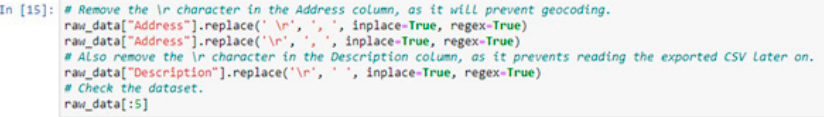
Figure 9. Sample code fixing typos and extra spaces.